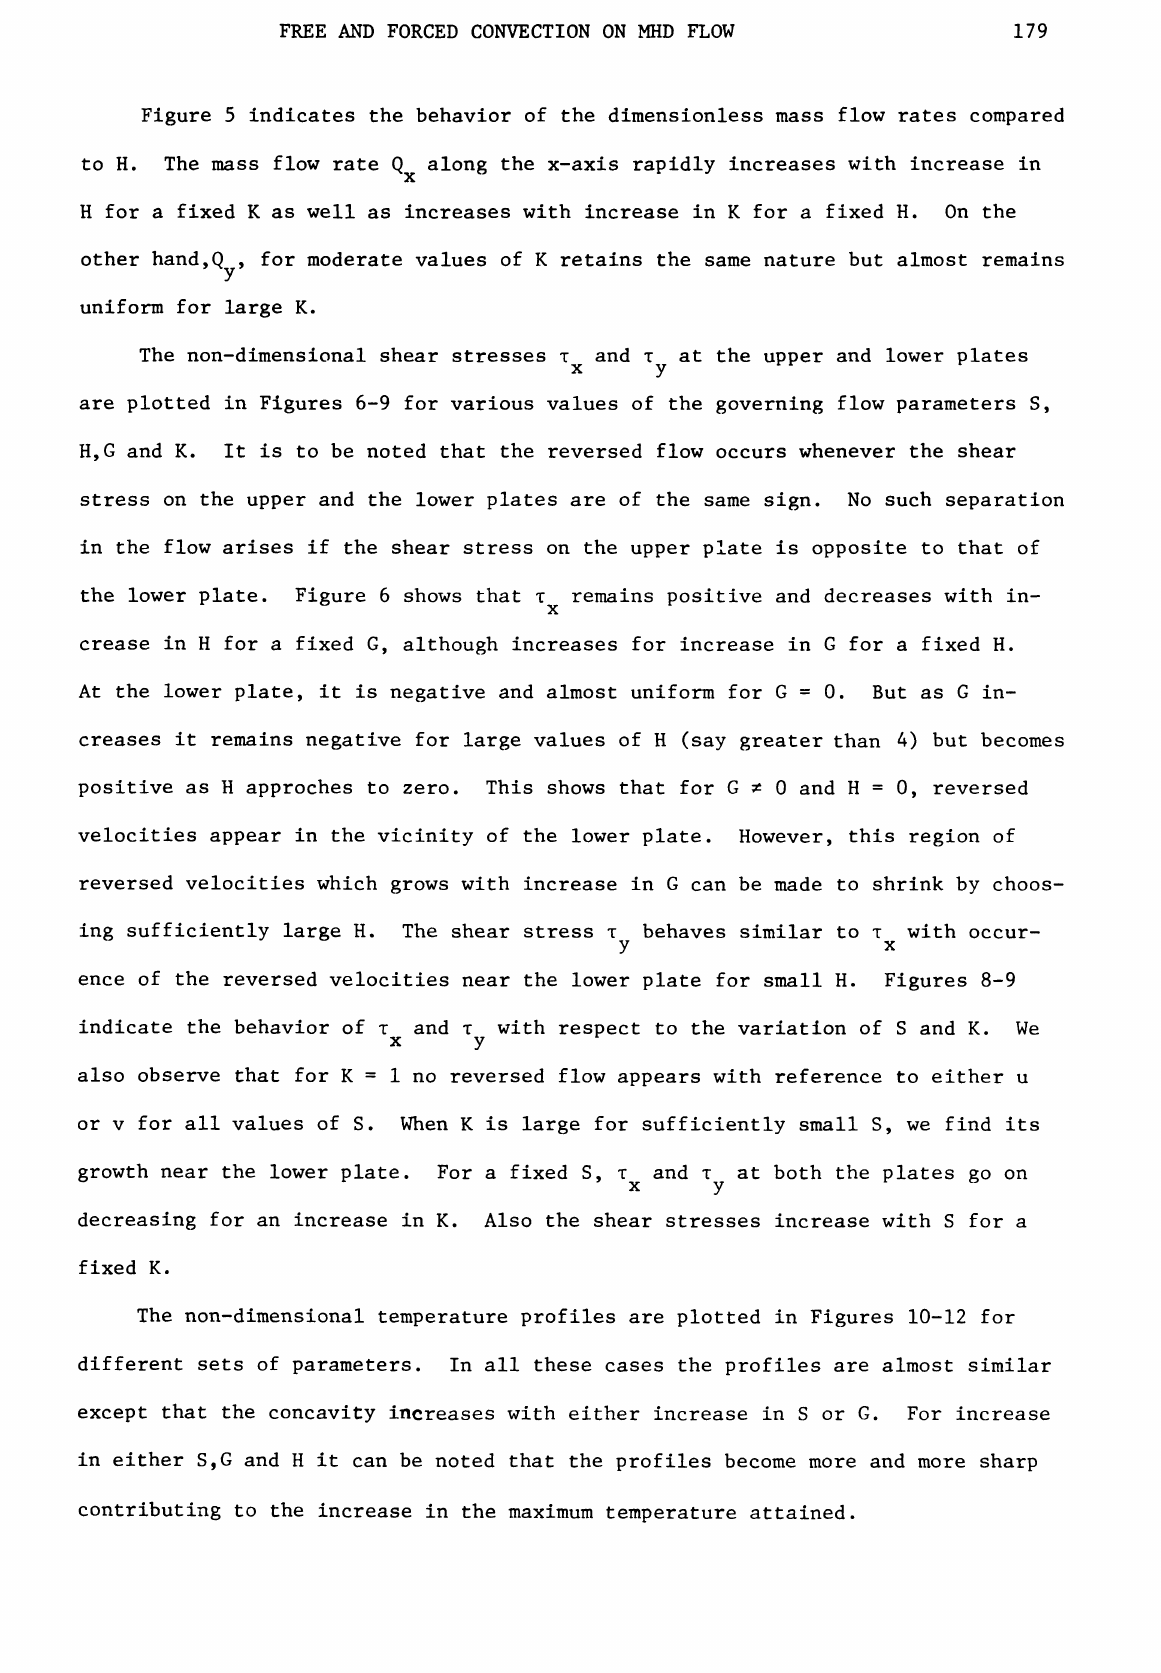
Figure 5 indicates the behavior of the dimensionless mass flow rates compared to